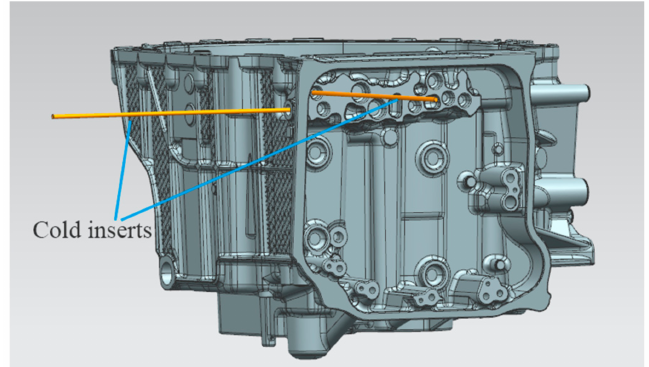
Figure 11. 3D model after adding cold inserts.